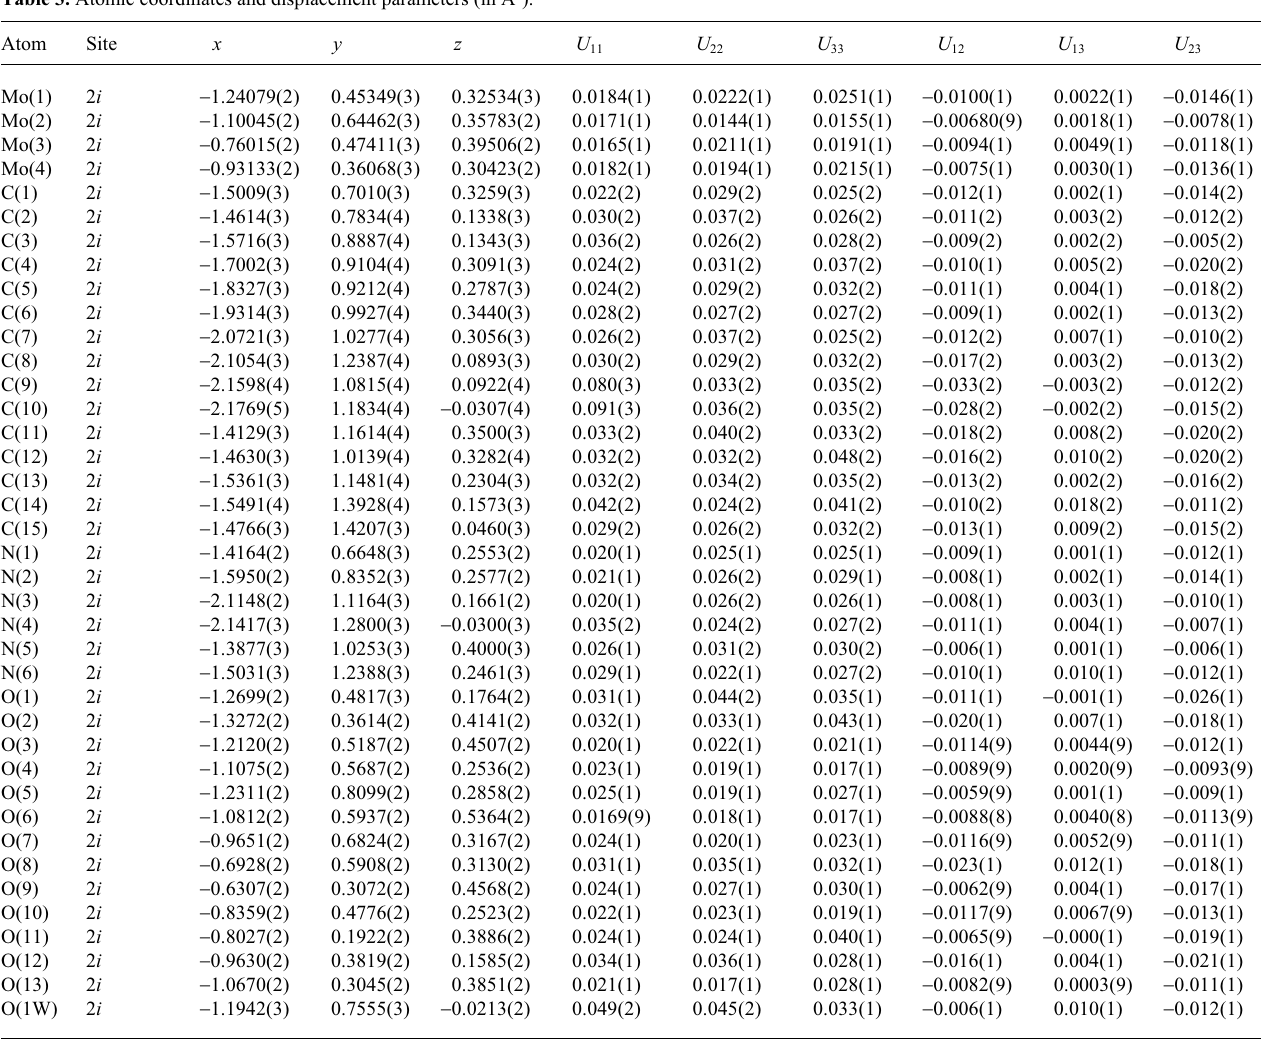
Table 3. Atomic coordinates and displacement parameters (in Å 2 ).